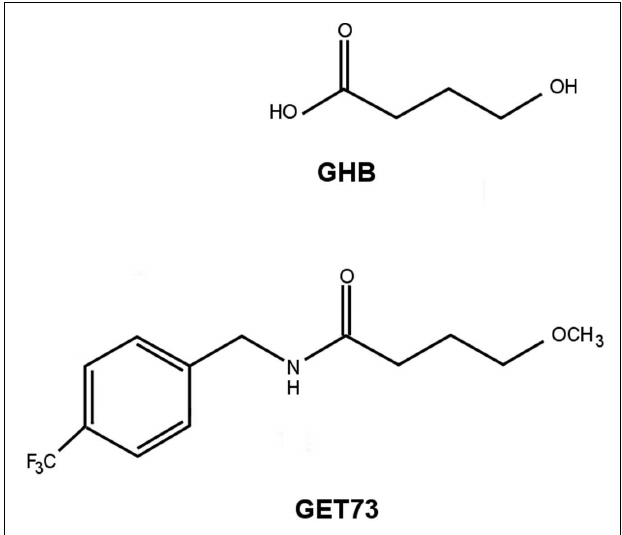
FIGURE 1 | Molecular structure of GHB and